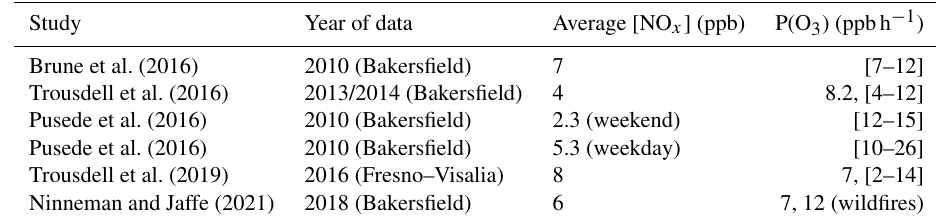
Table 2. A summary of reported midday ozone photochemical production rates in the southern